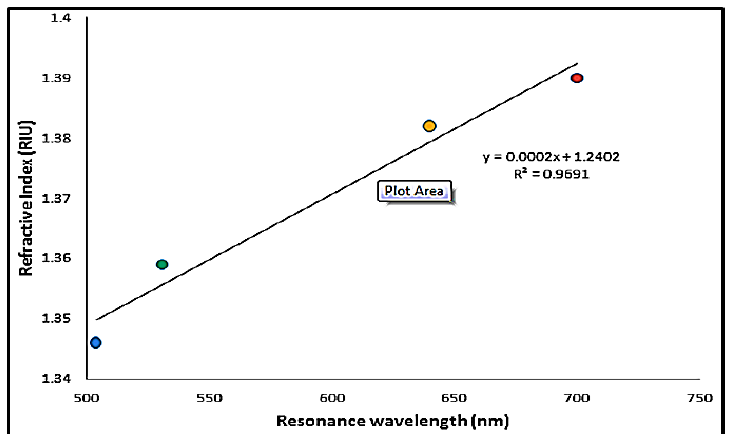
Fig.5: Refractive index as a function of resonance wavelength for the sensor with gold layer. The curve fitting is done on this figure according to equation y=0.0002x+1.2402.